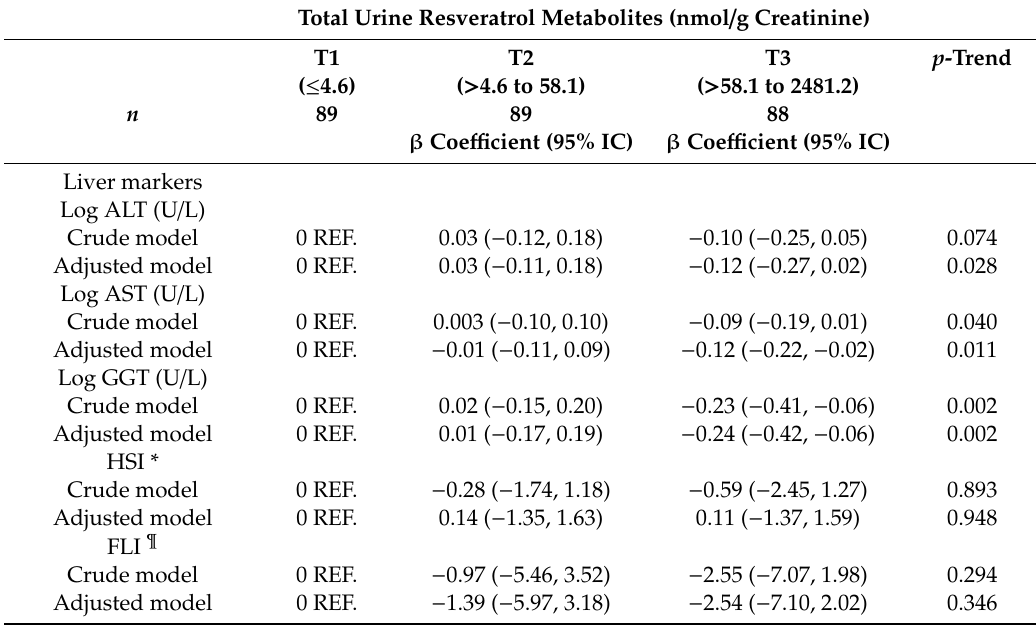
Table 5. Linear regression analysis evaluating the associations between total urine resveratrol (independent factor) and liver status markers (dependent factor) in participants with